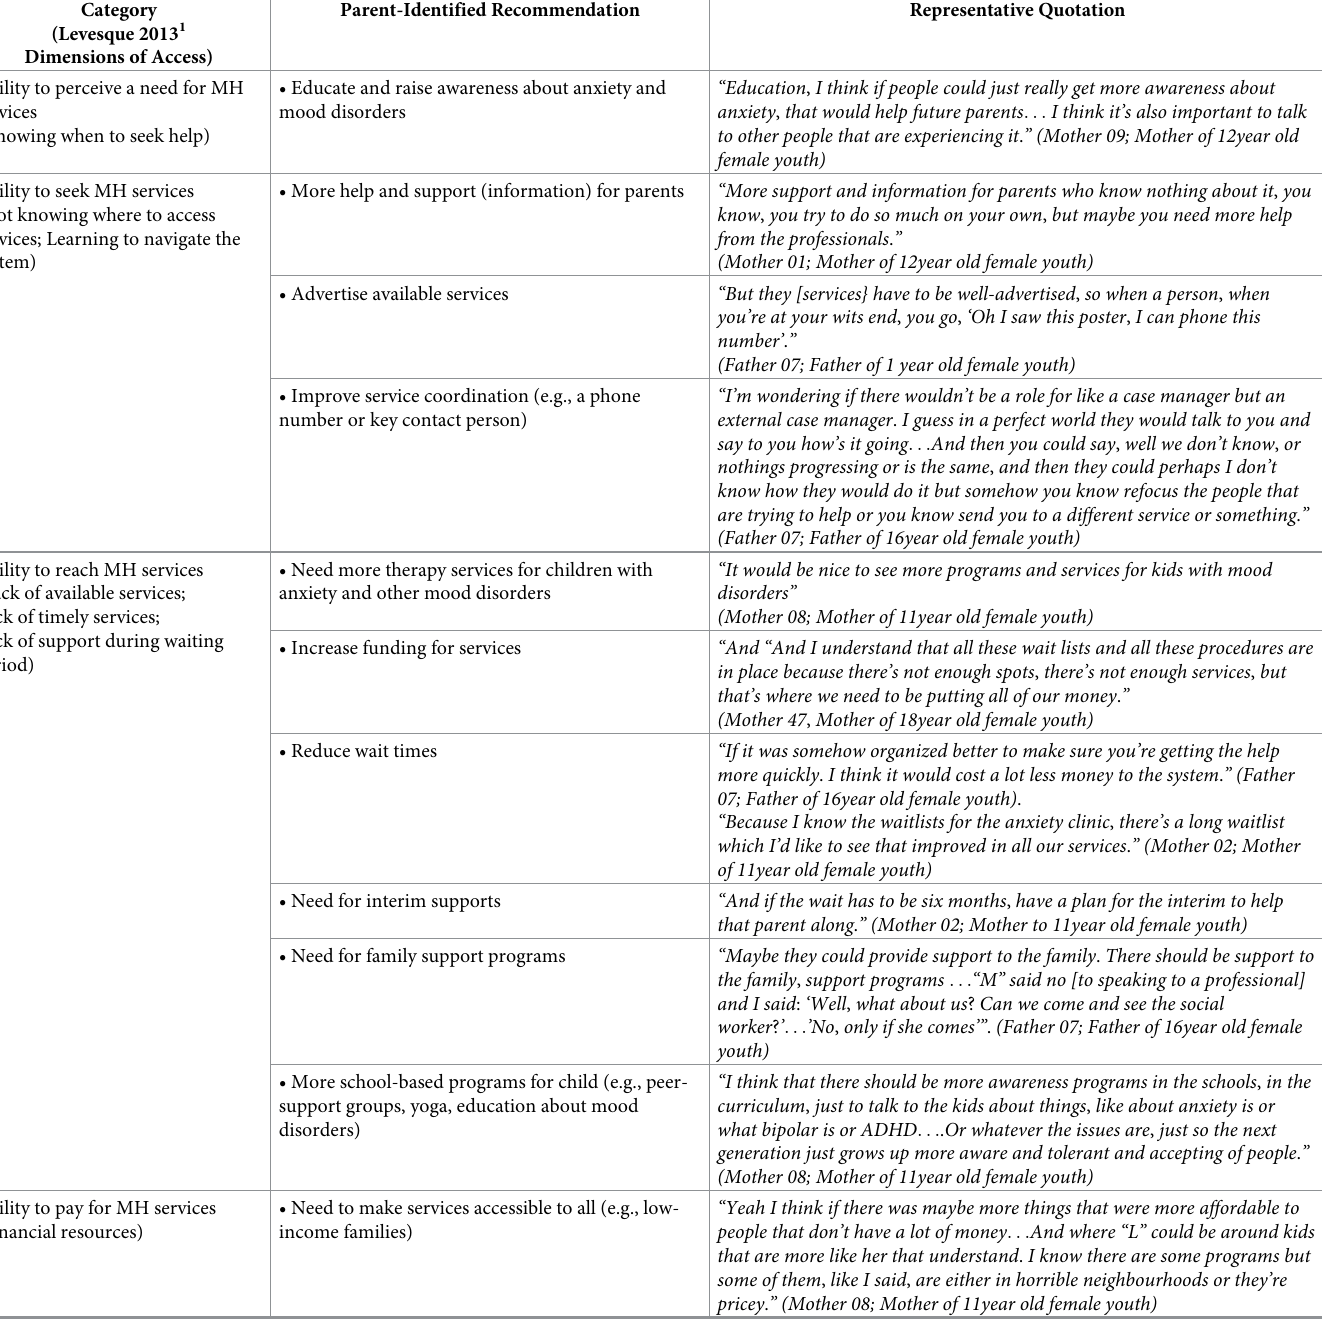
Table 2. Parent-identified recommendations for improving service access by dimension of